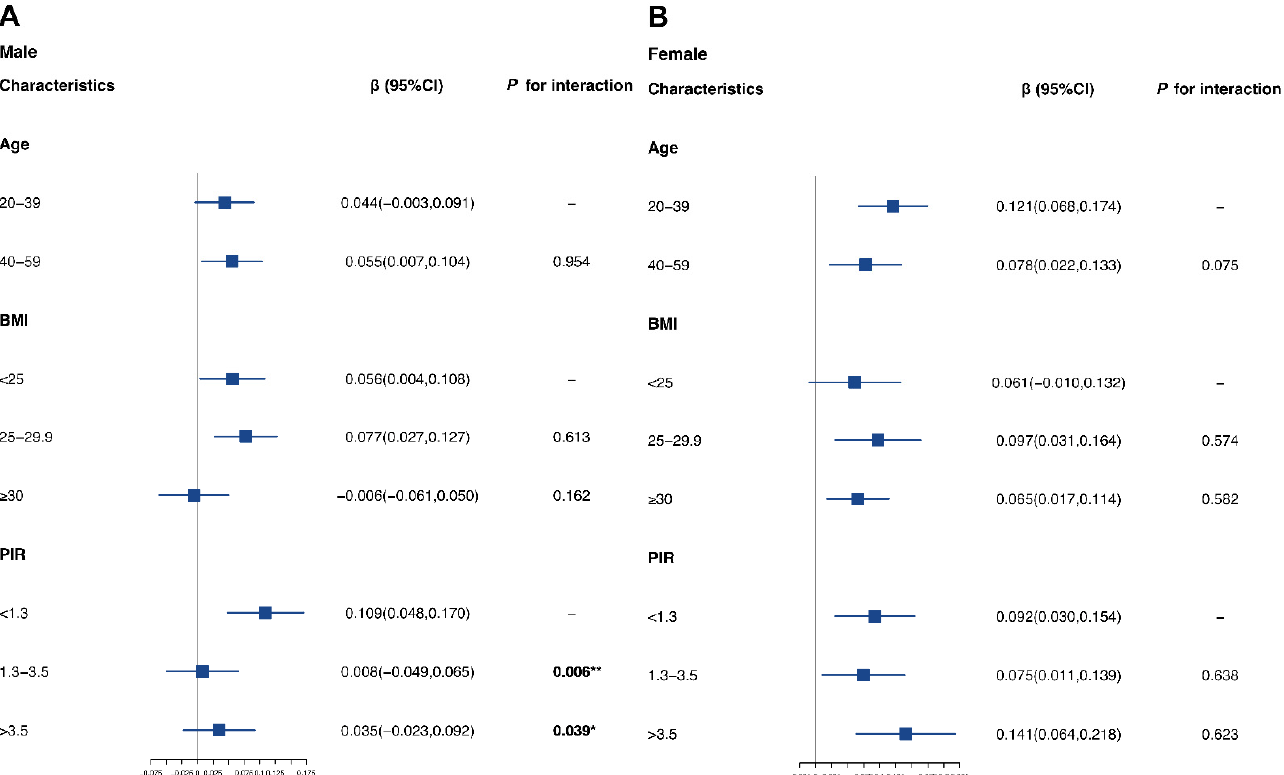
Figure 3. Stratified analyses on male and female subpopulations: ( A ) Stratified analysis of Mn and VAT mass in males. ( B ) Stratified analysis of Mn and VAT mass in females. Models were all adjusted for age, race, educational level, BMI, marital status, PIR, smoking status, 24 h alcohol consumption, physical activity, 24 h energy intake, and 24 h fat intake. The p -value for cross products of ln-transformed Mn levels and related stratified variables was calculated to estimate the potential interaction. *: p value < 0.05; **: p value < 0.01.